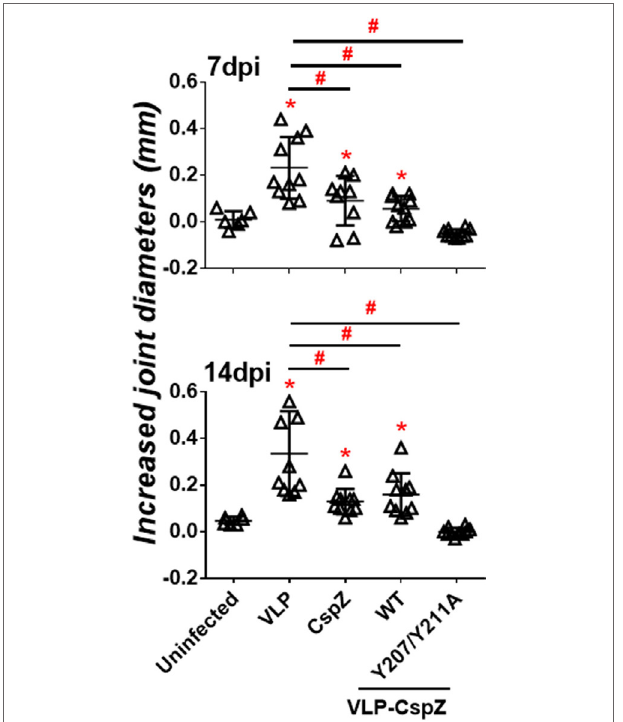
FigUre 4 | Immunizing mice with VLP-CspZ-Y207A/Y211A prevented joint swelling compared to virus-like particle (VLP) or VLP-CspZ vaccination. Ten C3H/HeN mice were vaccinated with VLP (“VLP”), CspZ (“CspZ”), VLP-CspZ (“VLP-CspZ-WT”), or VLP-CspZ-Y207A/Y211A (“VLP-CspZ-Y207A/Y211A”) prior to infection with 10 4 Borrelia burgdorferi strain B31-A3. The diameters of tibiotarsus joints were measured at ( top panel ) 7 and ( bottom panel ) 14 days post-infection, and from uninfected mice of the same age. The joint size of six uninfected mice was also included as negative control. The increased joint diameters were derived from subtracting the group average tibiotarsus joint diameter prior to infection (0 days post-infection). Data shown are the mean ± SD of 6 (uninfected) or 10 (all others) mice per group. Statistical significance ( p < 0.05) of differences in tibiotarsus joint diameters of each group relative to uninfected mice were determined using a one-way ANOVA test and post hoc analysis and are indicated (“*”). Significant differences ( p < 0.05) between infected groups are indicated (“ #